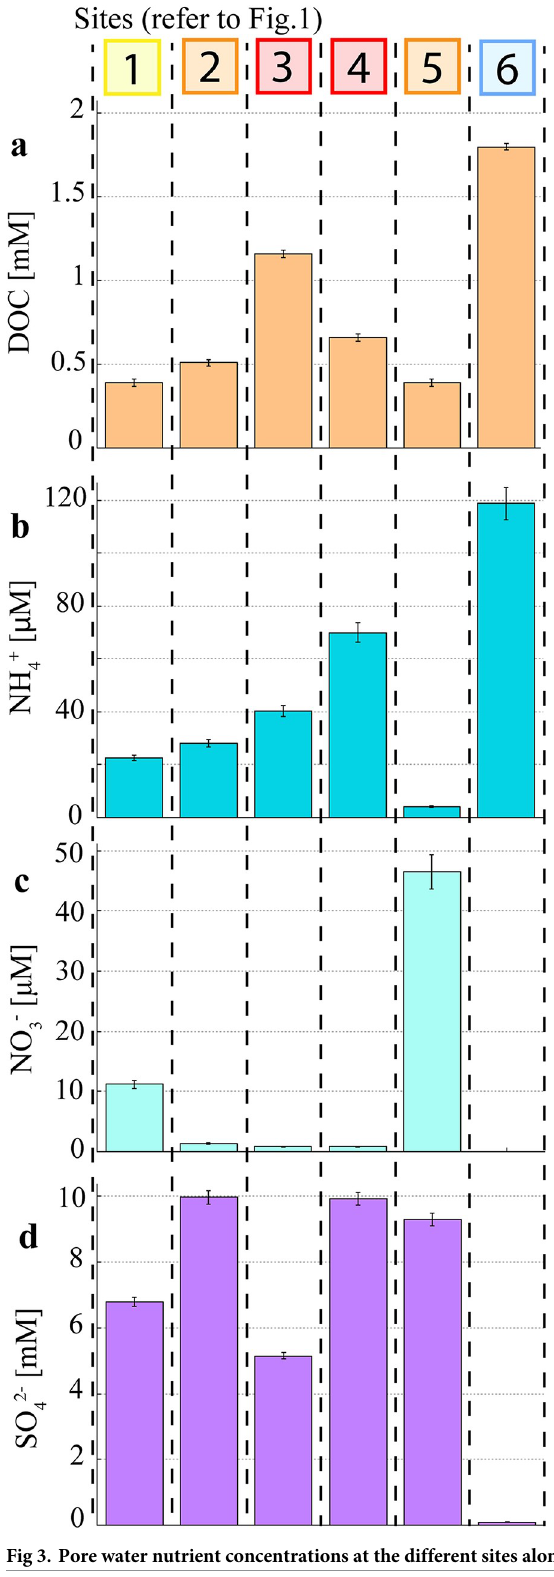
Fig 3. Pore water nutrient concentrations at the different sites along the Burnett River estuary.